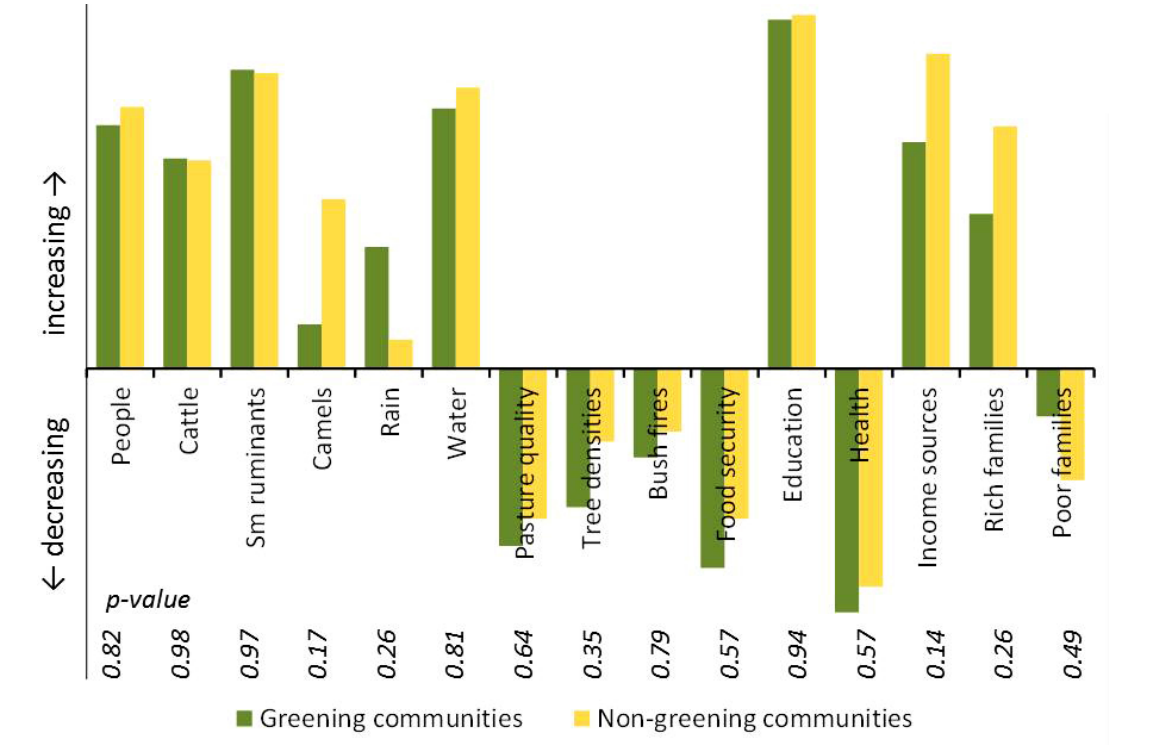
Fig. 9. Trends in matrix scores of 15 variables over three decades averaged by greening communities and nongreening communities. The P -value is a measure of significance of the difference between the greening